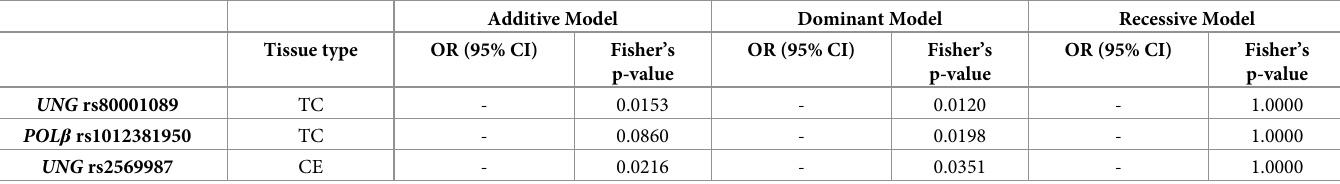
Table 10. Analysis of gene variants in post-mortem brain tissue samples based on genetic